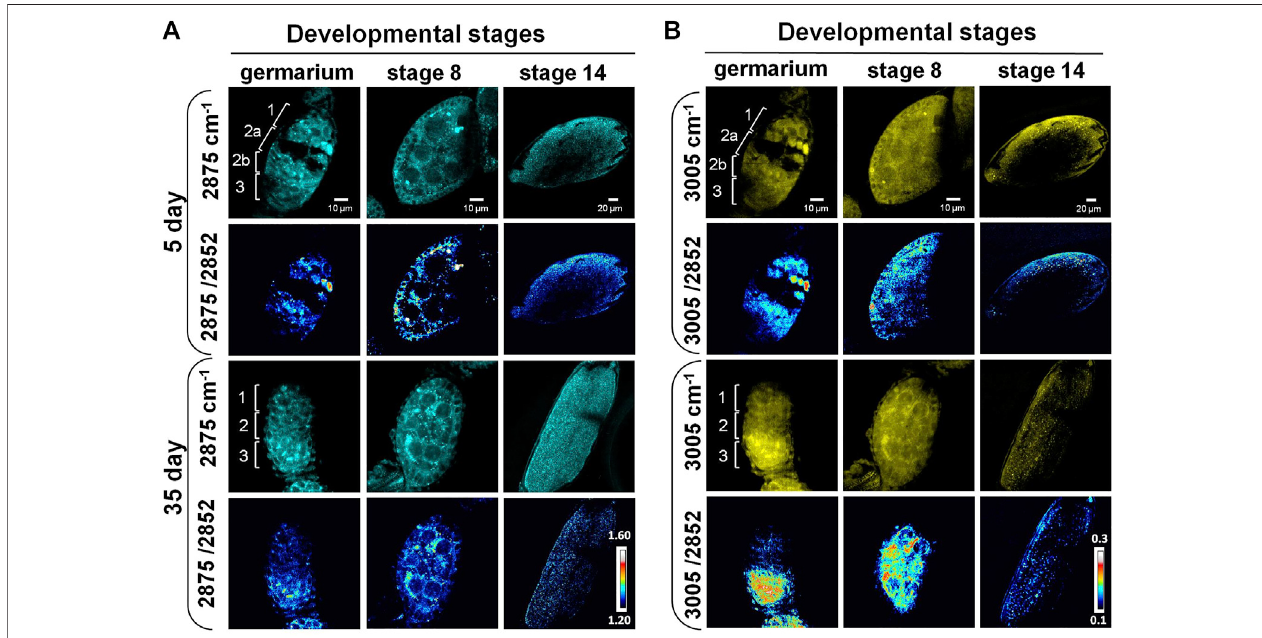
FIGURE 3 | SRS imaging of lipid subtypes ’ change in developing follicles of aging Drosophila . (A) SRS imaging at 2,875 cm − 1 of 5- and 35-day ovaries. The ratiometric images of 2,875 cm − 1 /2,852 cm − 1 were used to evaluate the concentration and distribution of saturated lipids. The images showed higher saturated lipid contentinregions1and2aofthegermariumsinyoung fl ies,butitwasreducedinthegermariumsof35-day-old fl ies.Saturatedlipidsinregion2bweremainlylocalizedin the lipid droplets inside the nurse cells of 5-day-old fl ies, but they were condensed to the bar-shaped structures in 35-day-old fl ies. At stage 8, saturated lipid was visualized in the cytoplasm of germ cells in both young and old fi les, but it was reduced in the surrounding follicle cells in old fi les. The level of saturated lipids at stage 14 wasreduced in old fl ies compared with youngones. Scale bar, 10 µm in germariumand stage 8, and 20 µm stage 14. (B) SRS imaging at 3,005 cm − 1 of5- and 35-day ovaries.Theratiometricimagesof3,005 cm − 1 /2,852 cm − 1 wereusedtoevaluatetheconcentrationanddistributionofunsaturatedlipids.Unsaturatedlipidswerelargely reducedinregion1ofthegermariumduring fl yaging.However,theytendedtobeaccumulatedinregion3inold fl ies,wheregermcellswerelocalized.Thedistributionof unsaturated lipids is consistent in repeated experiments for stage 8 follicles in old fl ies. Compared with the young fl ies, the content of unsaturated lipids in old fi les germ cells(nurse cellsandoocytes)wasincreased, butitwasreducedinthesurrounding folliclecells(somatic cells).Thelevelofunsaturatedlipidsatstage 14wasreducedin old fl ies compared with the young ones. Scale bar, 10 µm in germarium and stage 8, and 20 µm stage